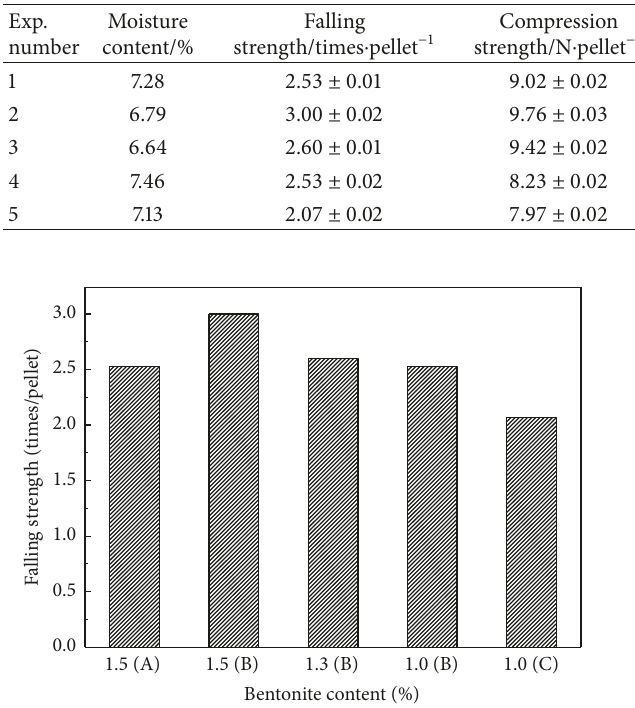
Figure 5: Effect of different types and proportions of bentonite on the falling strength of the ball.